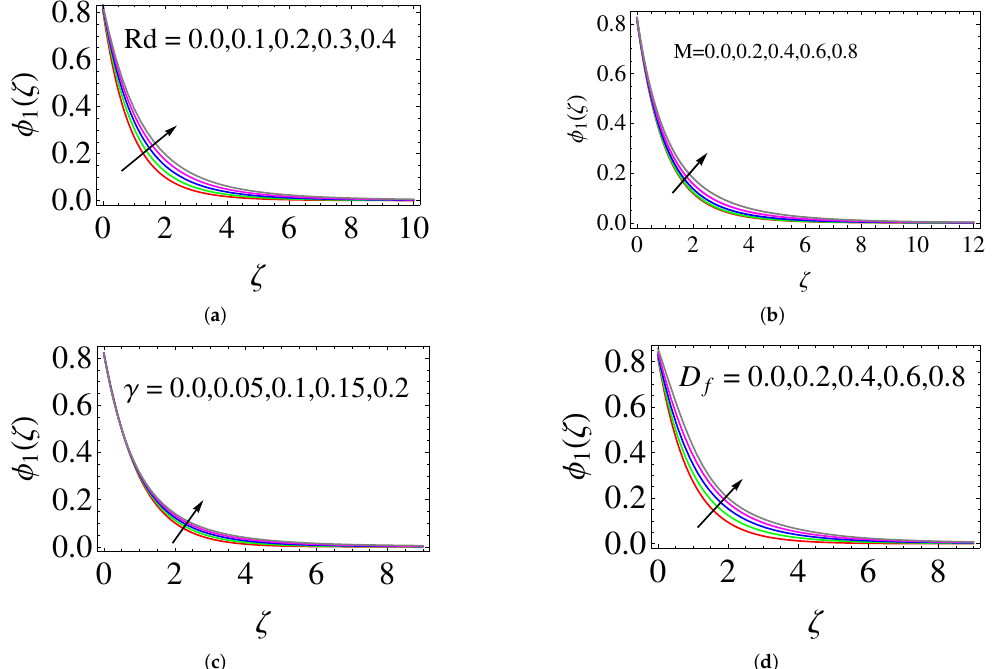
Figure 5. Influences of ( a ) thermal radiation ( Rd ) , ( b ) magnetic ( M ) , ( c ) curvature ( γ ) and ( d ) Dufour number ( D f ) parameters on the temperature profile for Nt = 0.1, θ w = 0.1, Nb = 0.1, Pr = 1.4, Sc n = 1.9, Sc = 0.4, S r = 0.2, C r = 0.1, A = 0.1, G 1 = G 2 = G 3 = 0.1 and B 1 = B 2 = B 3 = 0.1.